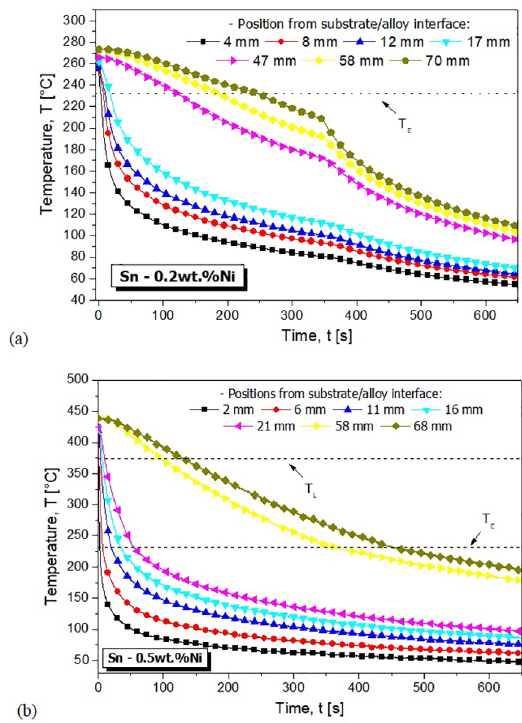
Figure 4. Experimental plots of eutectic growth rates and tip Figure 2. Thermal profiles generated through transient directional growth rates for: Sn-0.2 and 0.5 wt.%Ni alloys along the length of solidification of: (a) Sn-0.2wt.%Ni and (b) Sn-0.5wt.%Ni alloys DS the directionally solidified castings castings. T is liquidus temperature and T is eutectic temperature L E as pointed out inside the graphs The eutectic-related profiles in Fig. 3 and Fig. 4 (triangles and squares) depict higher cooling rates for can be observed when the Sn-0.2 and